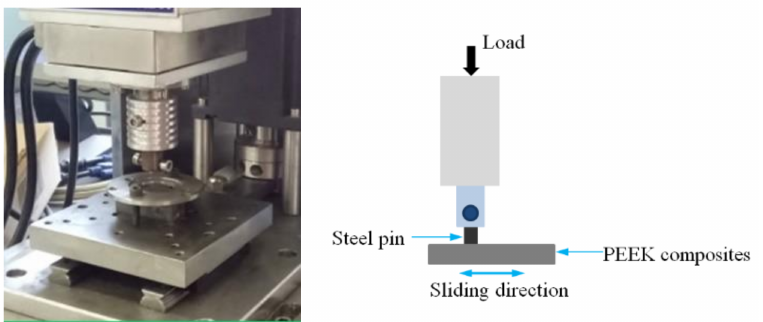
Figure 1. Schematic diagram of the pin-on-flat contact configuration of reciprocation sliding friction